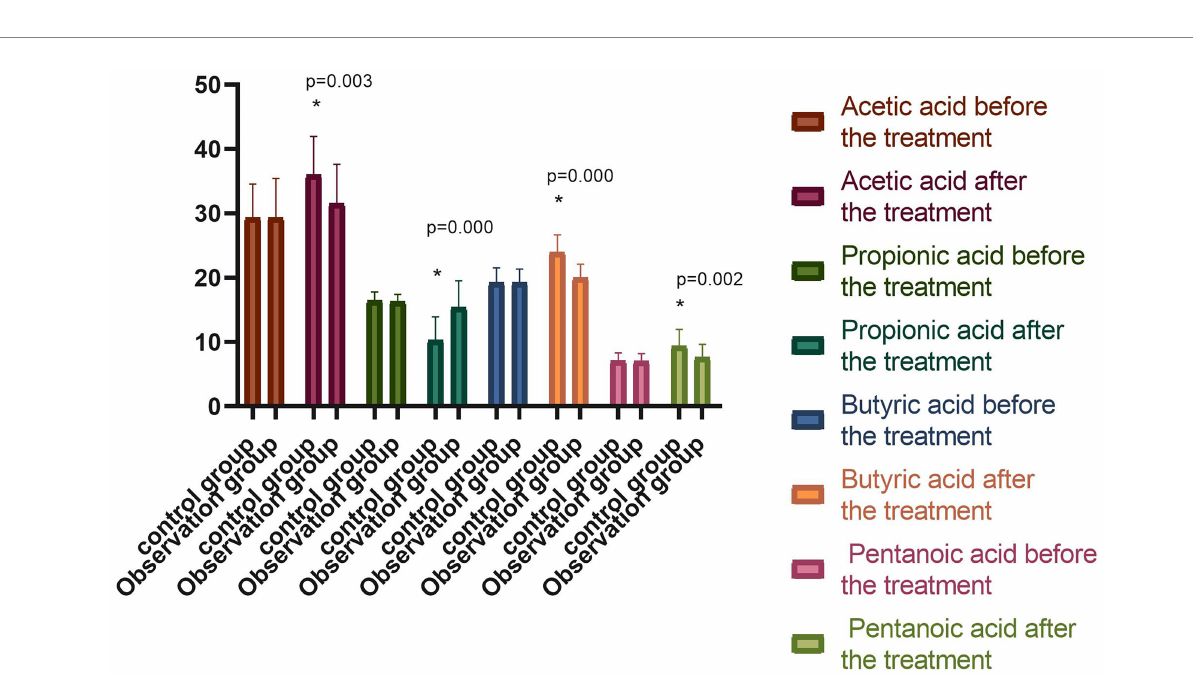
FIGURE 4 Comparison of the percentage of peak areas of metabolites of intestinal flora between the two groups before and after the treatment ( − x ± s ). Compared with the group before the treatment, * p <